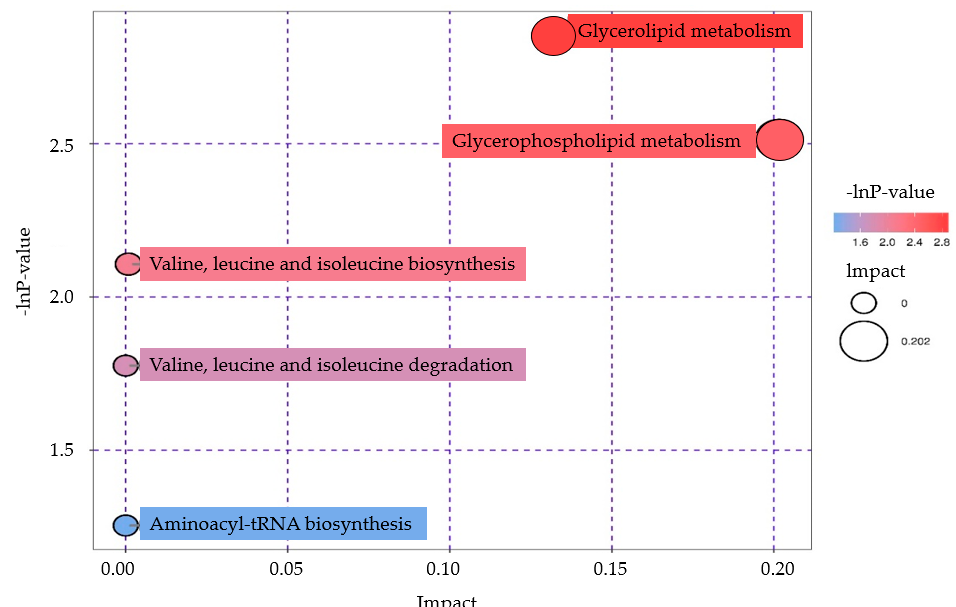
Figure 8. Pathway analysis diagram of group 1T versus group C.